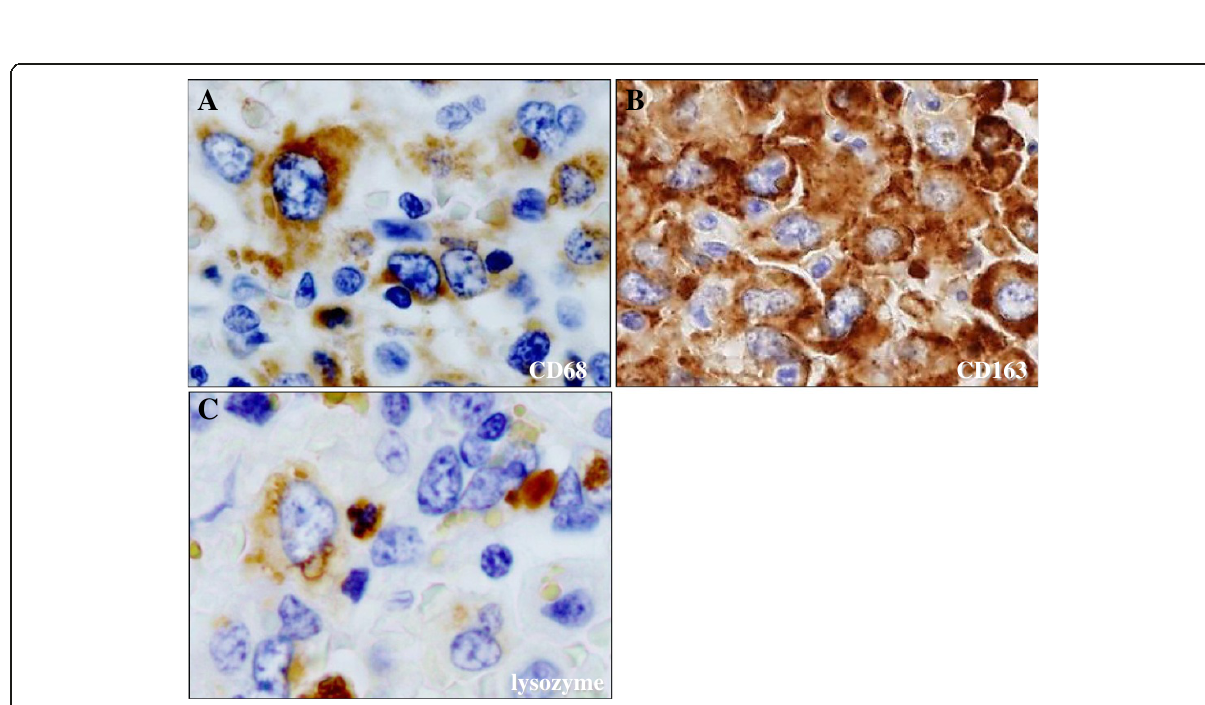
Figure 4 Immunohistochemical examination for the tumor cells of splenic HS. (A)(B)(C) These large tumor cells were specifically positive for CD68 (KP-1) ( A ), CD163 ( B ), and lysozyme ( C ), and many reactive histiocytes were also positive for CD163 (Original magnification ×